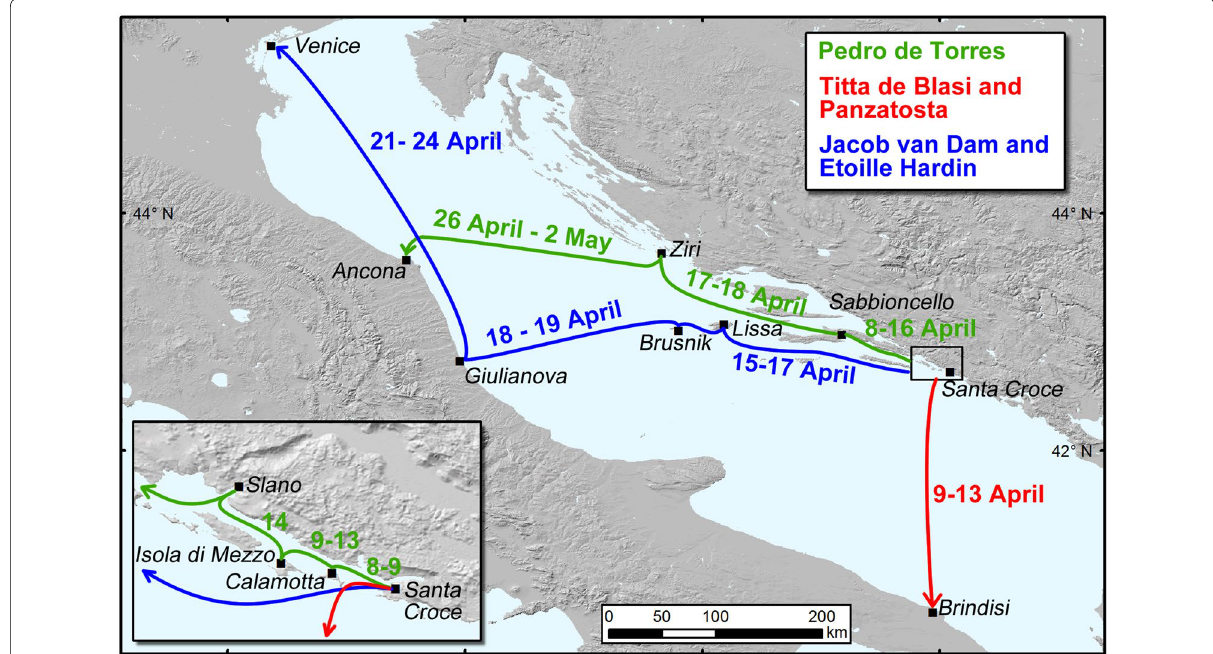
Fig. 2 Eyewitnesses leaving Ragusa after the 6 April 1667 earthquake. Pedro de Torres, archbishop of Ragusa, who found a temporary shelter in Ancona with 62 survived nuns; the Italian merchants Titta de Blasi and Panzatosta, who went straight back home, in Brindisi (Italy); Jacob van Dam, a Dutchman of a diplomatic team of 40, on route to Izmir and Constantinople, who travelled to Venice together with Etoille Hardin, a French trades- man. From Albini (2015), modified